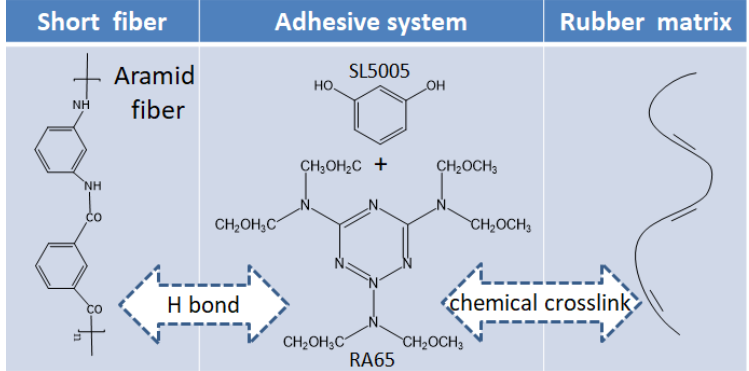
Figure 2. Mechanism of adhesion system.